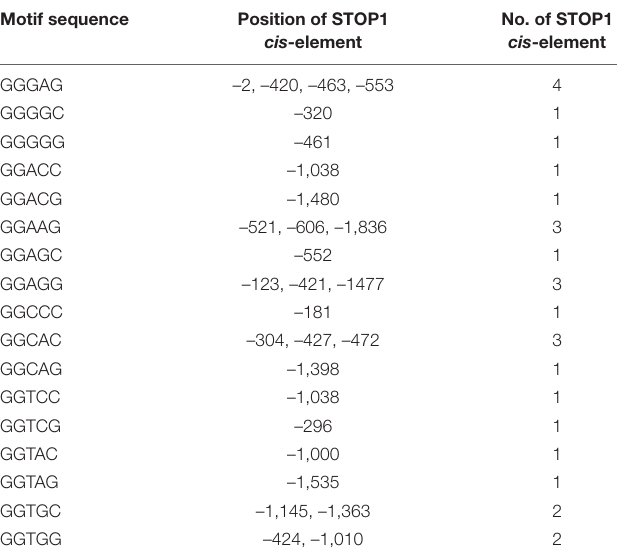
TABLE 1 | The number and position of sensitive to proton rhizotoxicity 1 (STOP1) cis -acting elements of SlAAE3-1